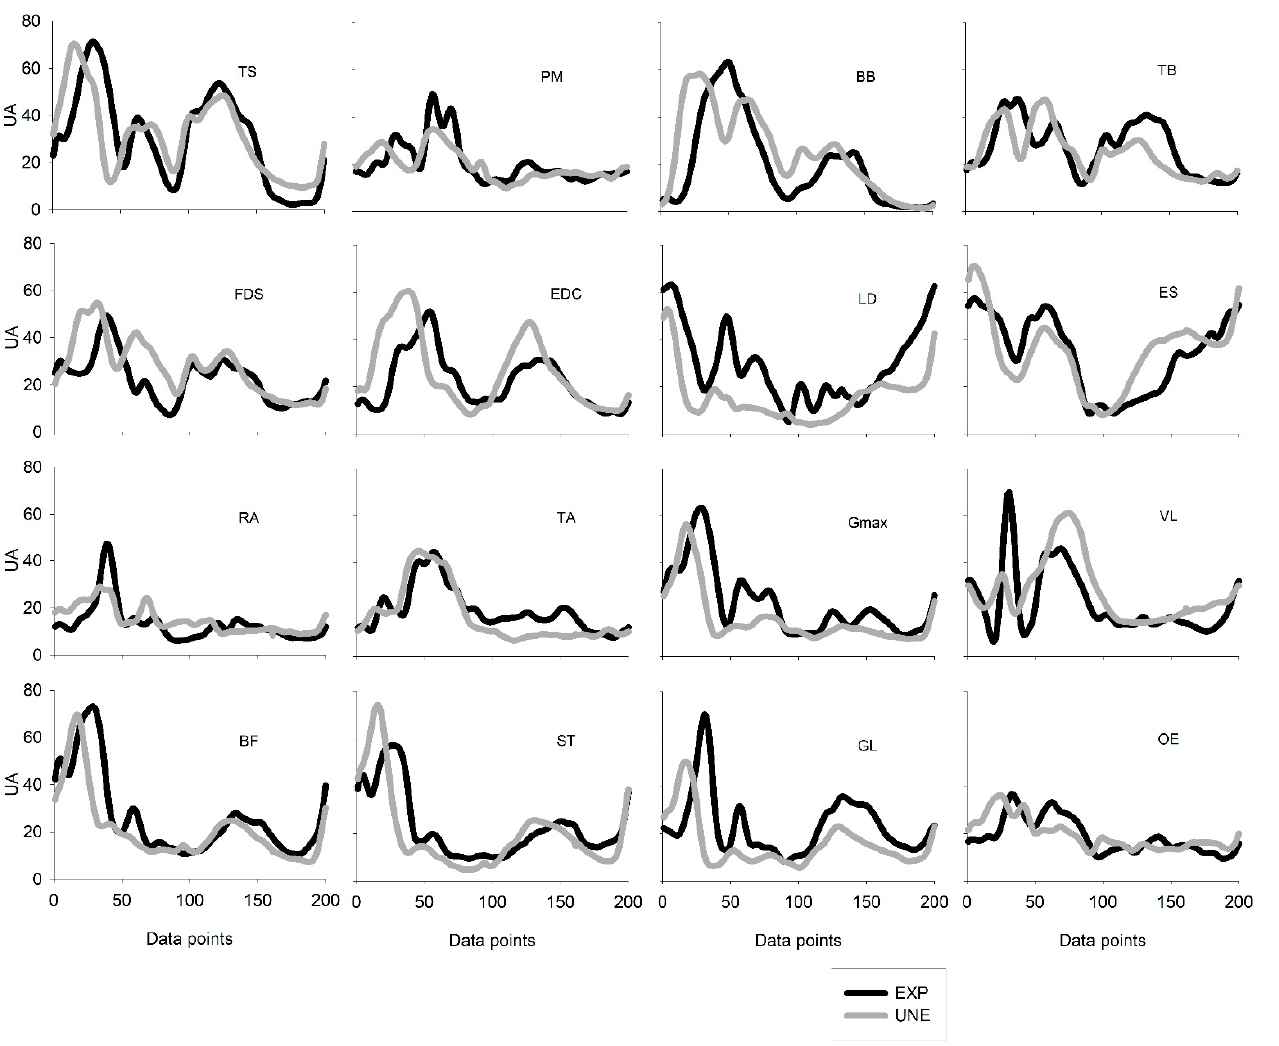
Figure 5. Averaged EMG envelopes (UA—arbitrary units) from 16 muscles obtained in weightlifters (EXP) and unexperi- enced participants during power clean cycle (200 time points).